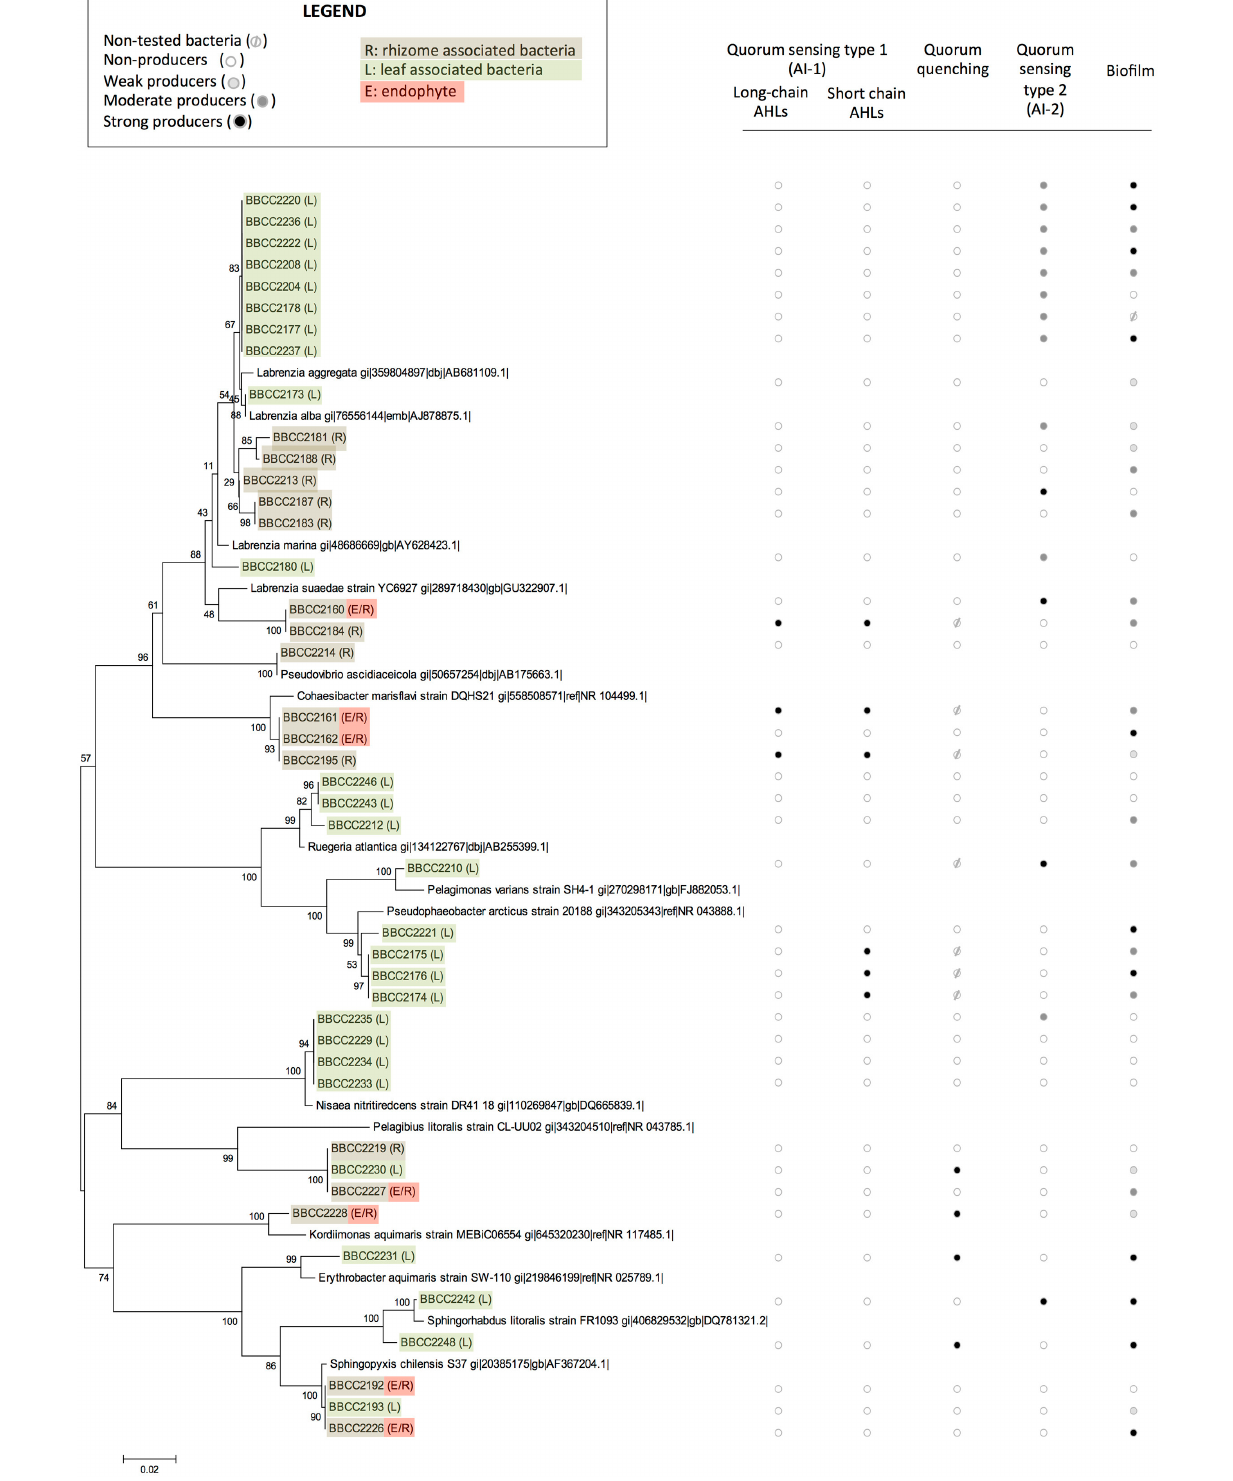
Frontiers in Marine Science | www.frontiersin.org